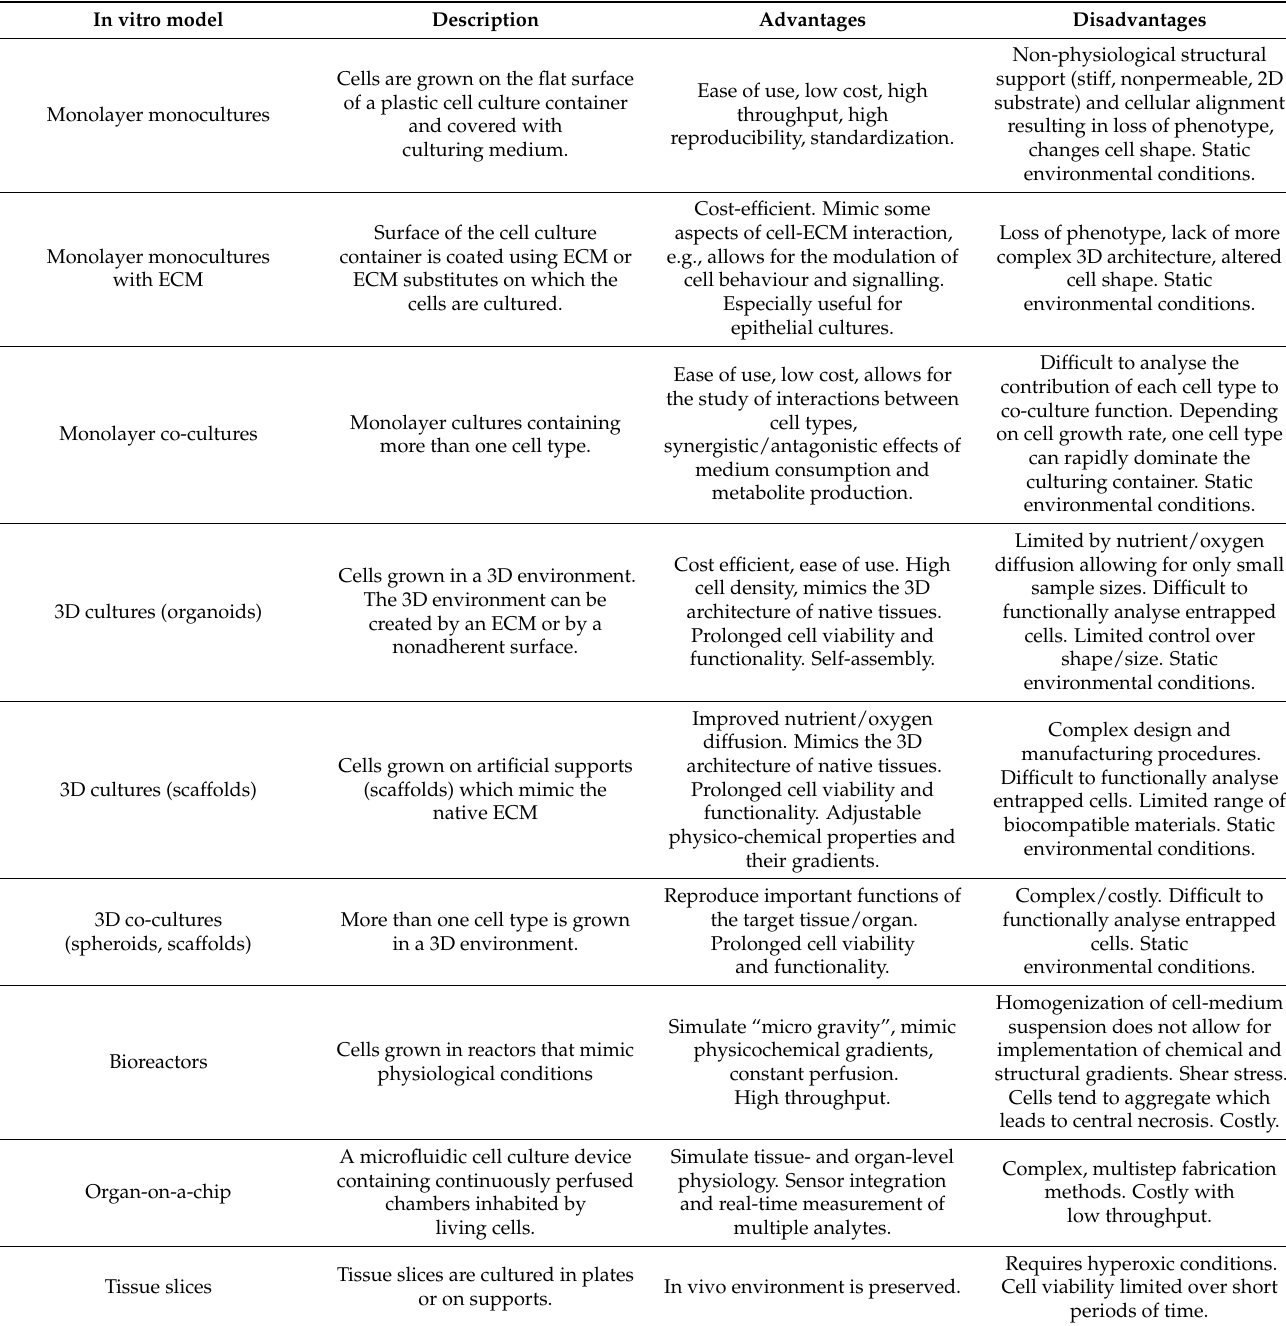
Table 1. Summary of different types of in vitro cell models categorized based on their